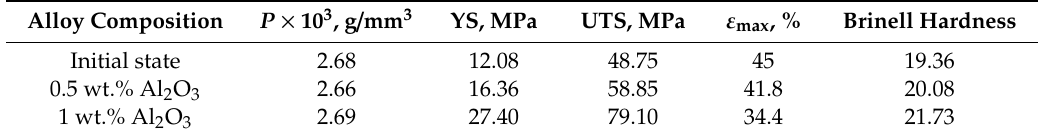
Table 1. Mechanical properties of the investigated Figure 4. Stress–strain curves obtained for the tensile test samples from investigated alloys: Al 1100: initial state; Al 1100/0.5 wt.% Al 2 O 3 ; Al 1100/1 wt.% Al 2 O 3 .